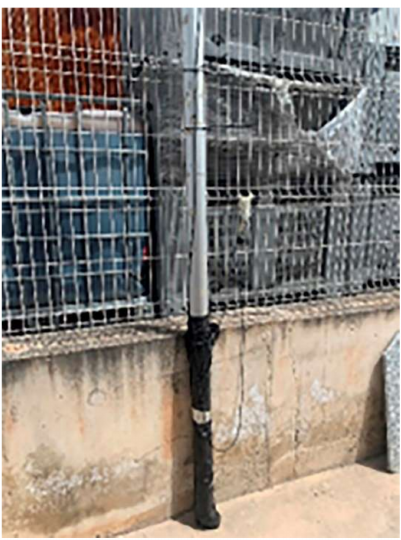
Figure 7. Detail of final